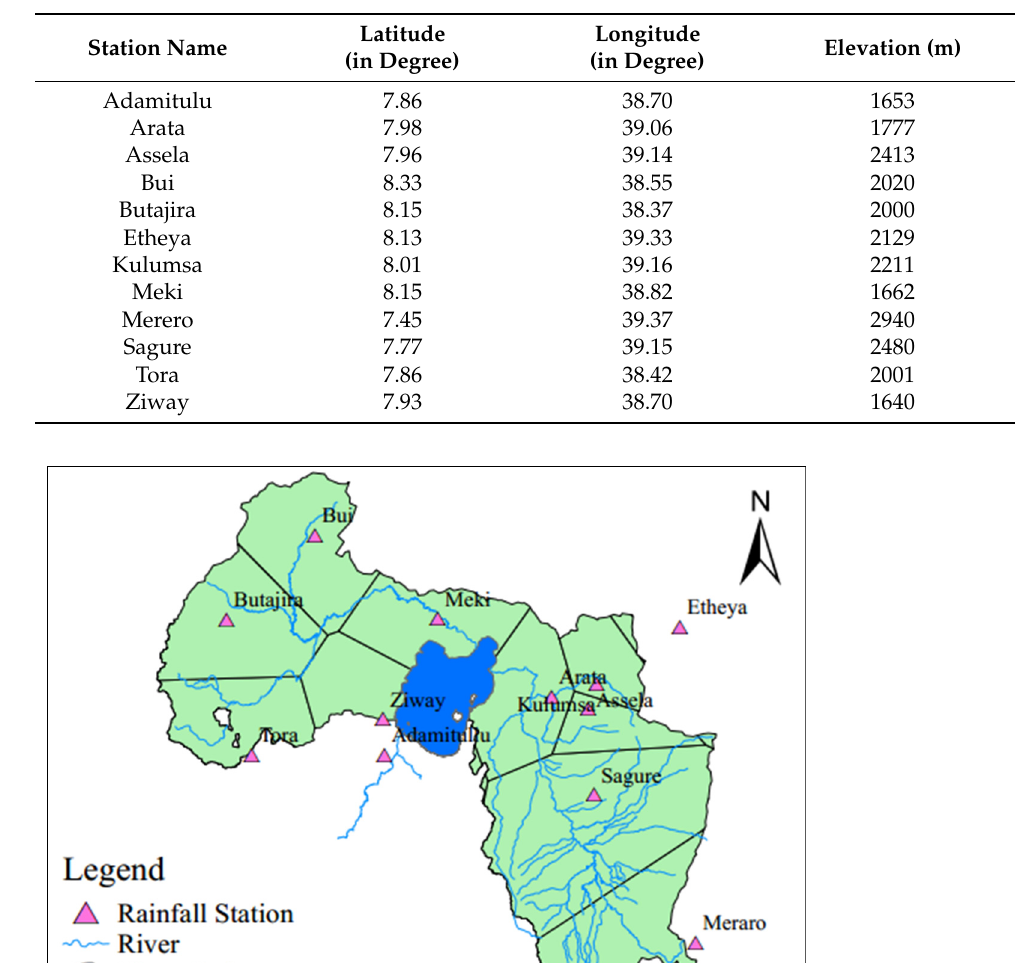
Table 1. List of the twelve rainfall stations over the Ziway Lake Basin.